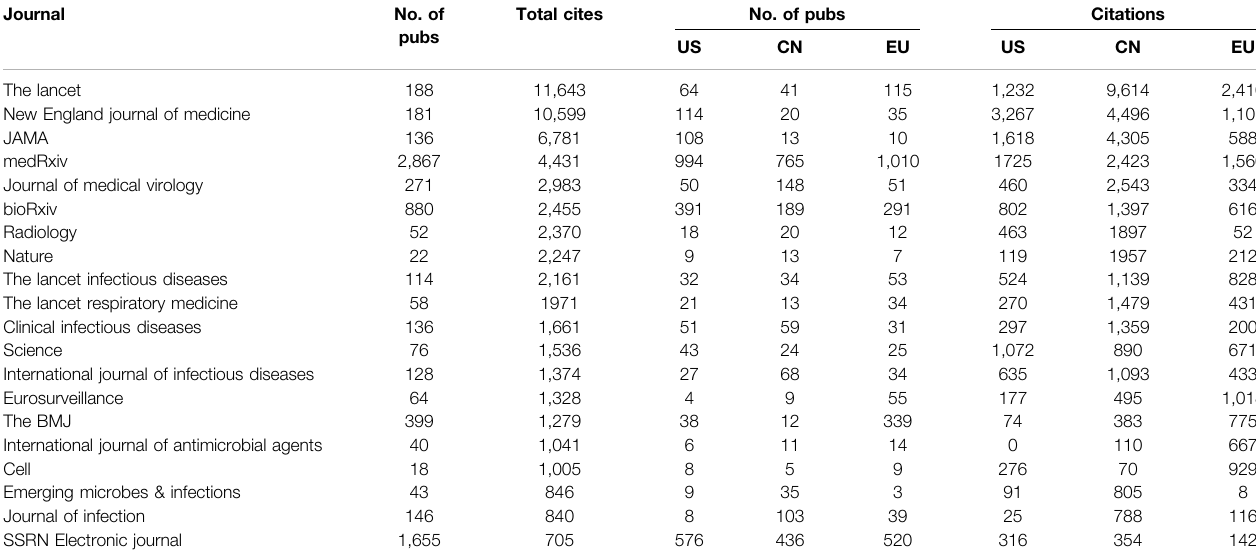
TABLE 1 | Regional representation of COVID research by publication venue. Publication venues include journals and preprint servers and are selected (and ordered) by number ofcitations toCOVID articles (TotalCites column). COVID research isde fi ned relative tothe boxed query in this report. All numbers arederived from Dimensions on May 24, 2020. Note that arXiv.org contains 1,013 publications related to COVID, however, the quality of address metadata and citation details of these papers in Dimensions does not currently allow it to be included in this